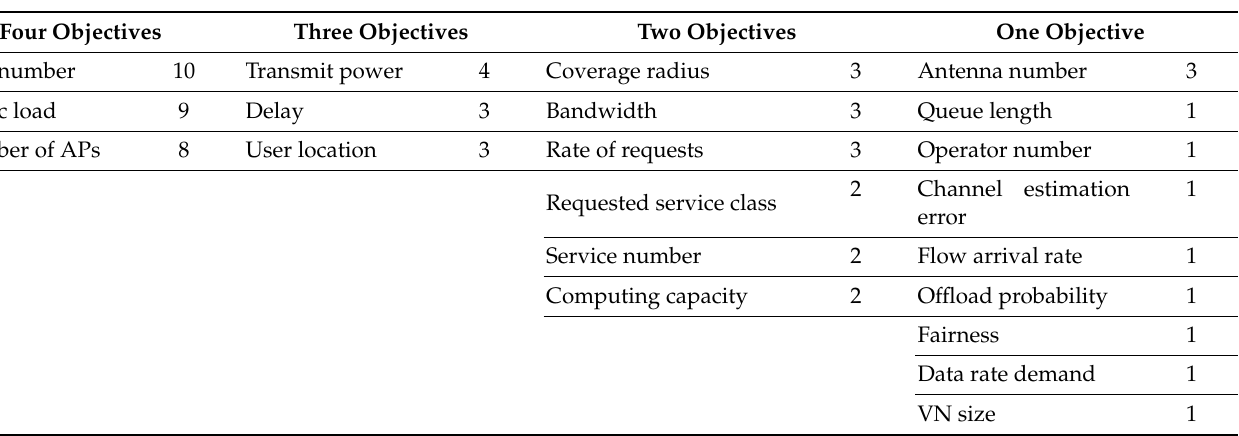
Table 2. Distribution of evaluation